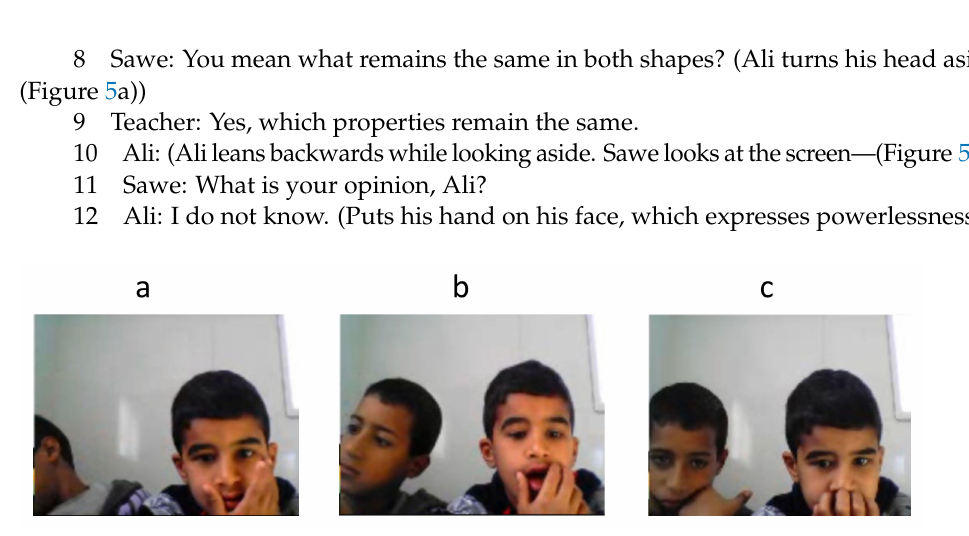
Figure 5. ( a ) Ali (left) turns his head aside; ( b ) Ali leans backwards while looking aside as Sawe looks at the screen; ( c ) Ali puts his hand on his face, expressing